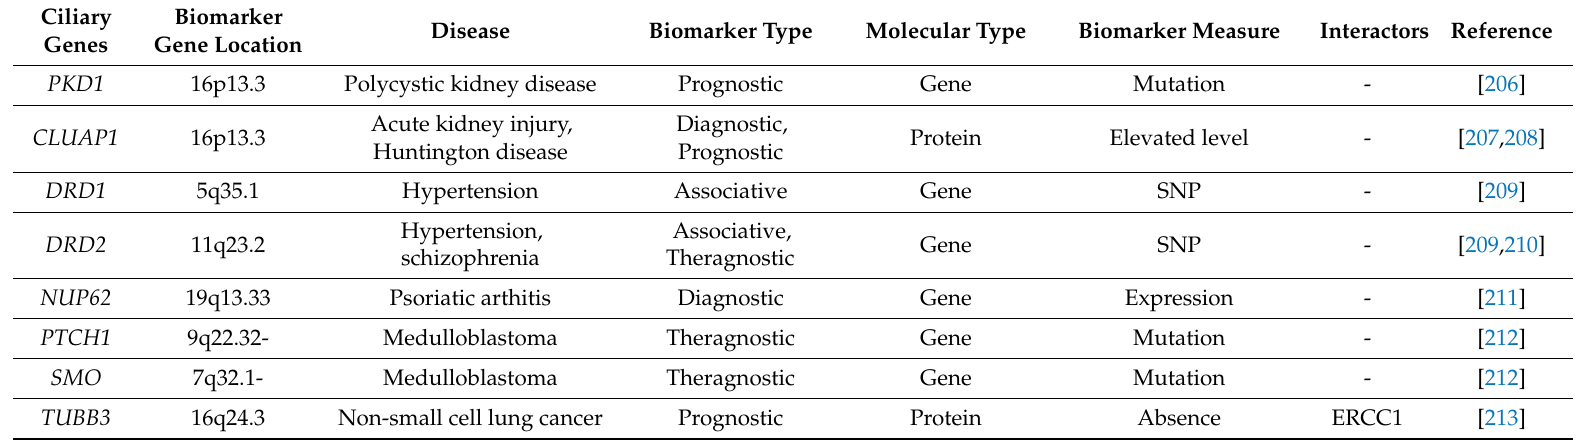
Table 3. List of ciliary genes as diagnostic, prognostic, theragnostic or associative biomarkers (from TTD—Therapeutic Target Database http: // db.idrblab.net / ttd / (accessed on 6 November 2019)